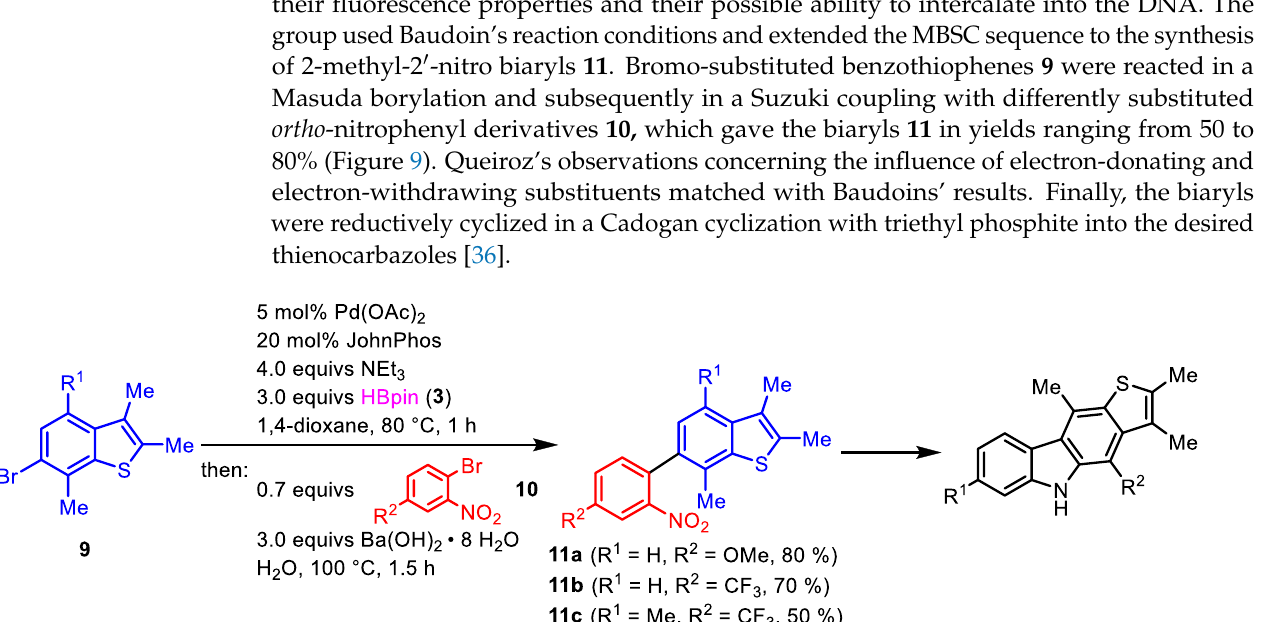
Figure 8. Order of the electronics of borylation and cross-coupling components in Baudoin’s one-pot MBSC sequence [35].